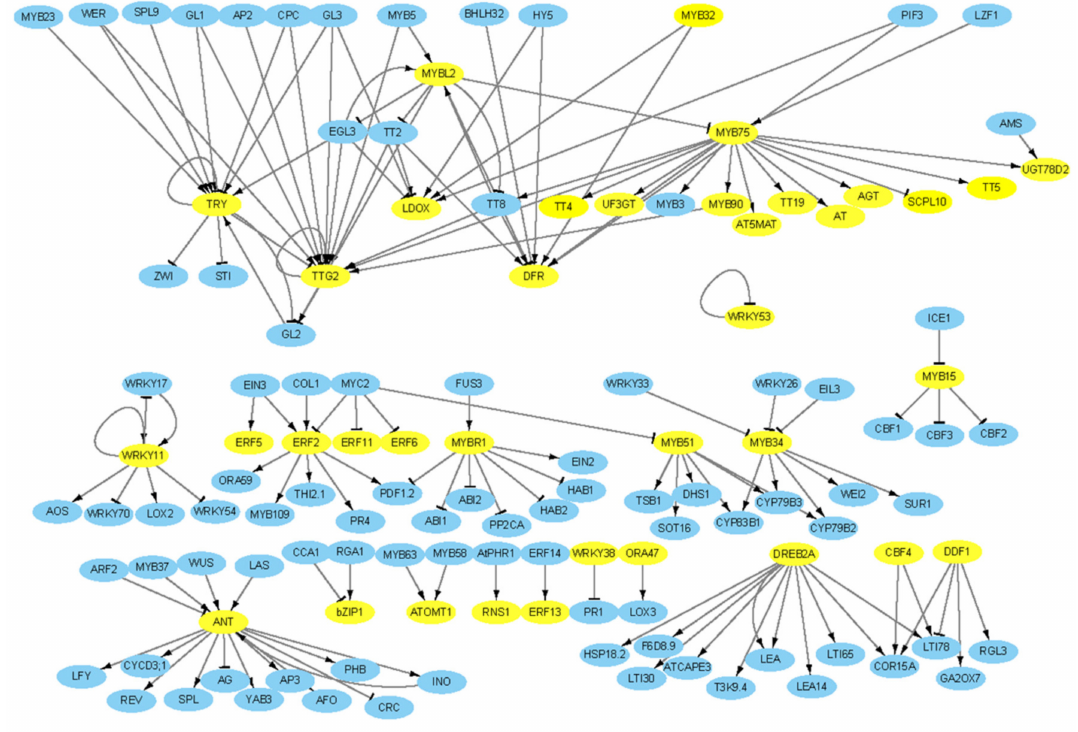
Figure 9. Gene regulatory network of anthocyanin biosynthetic genes and important transcription factors. DEGs detected from our transcriptome data are shown in yellow: other interactive genes involved in various functions including anthocyanin biosynthesis are shown in blue. Up tack ( ⊥ ) indicates repressors and arrow ( ↓ / ↑ ) indicates